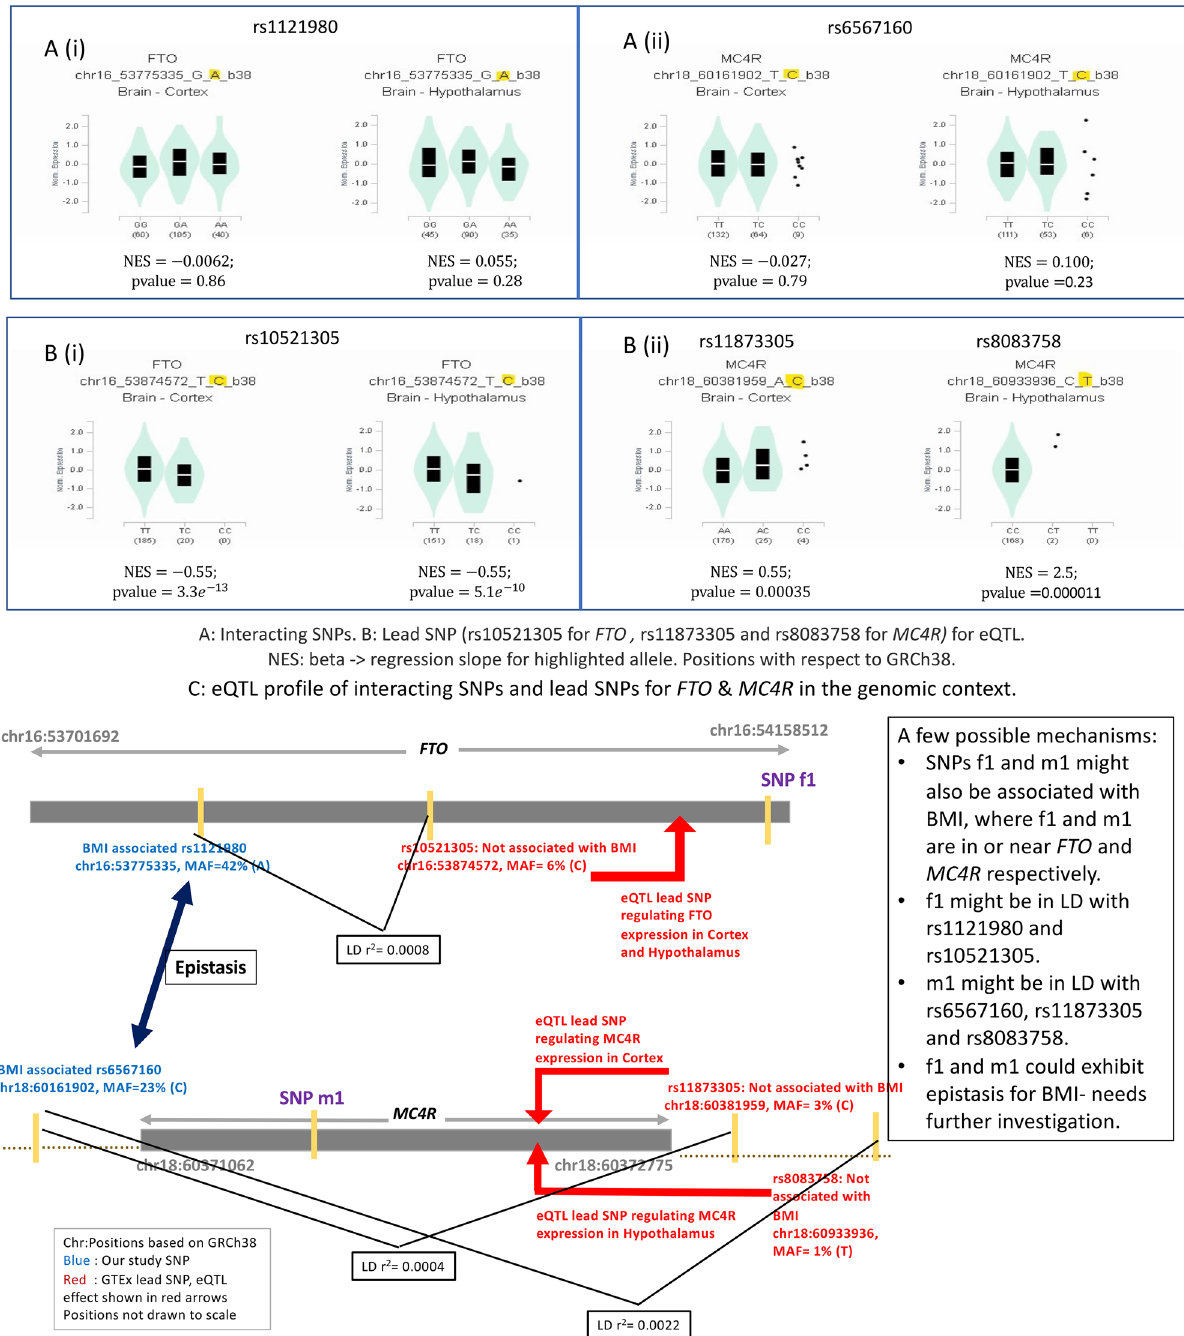
Figure 4. eQTL profile of FTO (i) and MC4R (ii) SNPs in relevant tissues. ( A ) eQTL profile of FTO (rs1121980) and MC4R (rs6567160) in brain cortex and hypothalamus. ( B ) eQTL profile of lead SNP of FTO (rs10521305) and lead SNPs of MC4R (rs11873305 and rs8083758 expressed in brain cortex and hypothalamus respectively). ( C ) eQTL profile of interacting SNPs and lead SNPs for FTO and MC4R in the genomic context. Possible mechanisms of action of epistatic SNPs in regulating expression of relevant